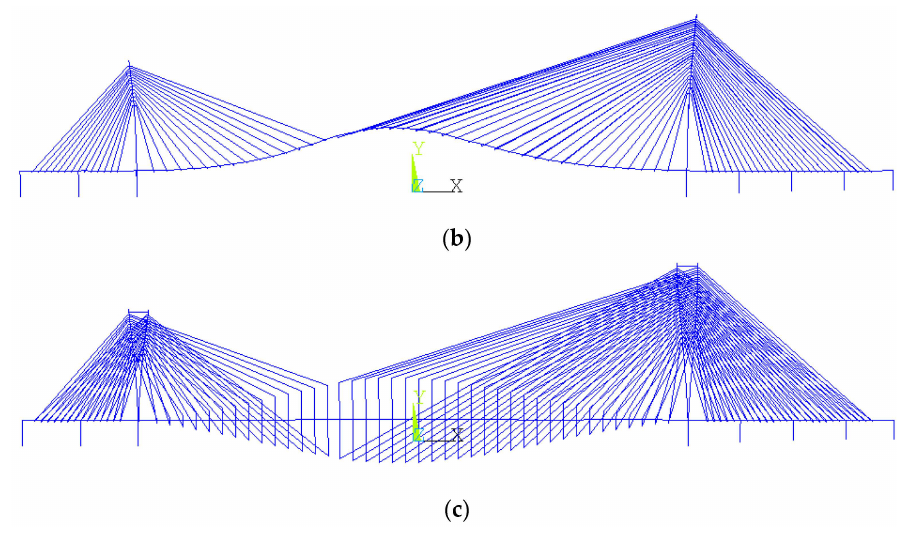
Figure 4. Fundamental modes of service state. ( a ) Lateral (0.3613 Hz); ( b ) vertical (0.2809 Hz). ( c ) torsional (0.6268 Hz).